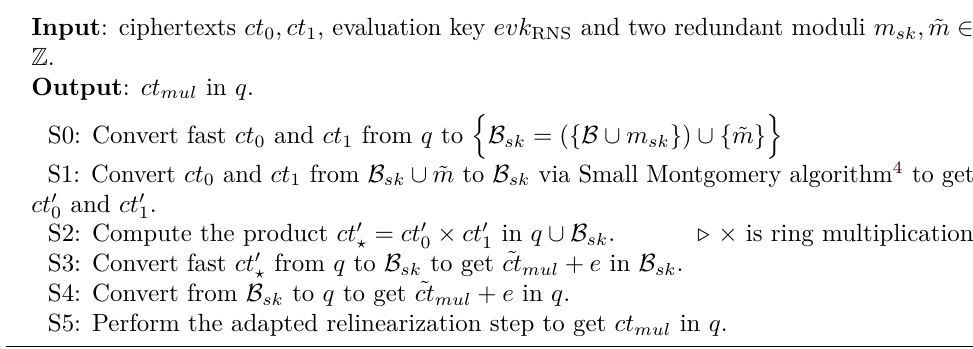
Algorithm 3 EvalMul RNS